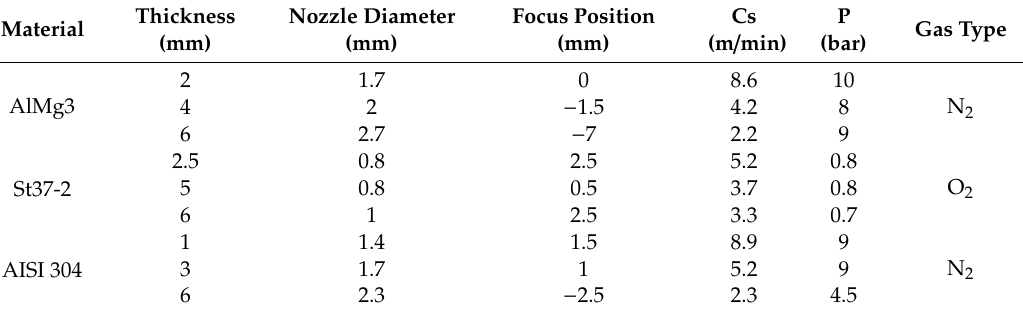
Table 4. Laser parameters adopted in experimental tests.